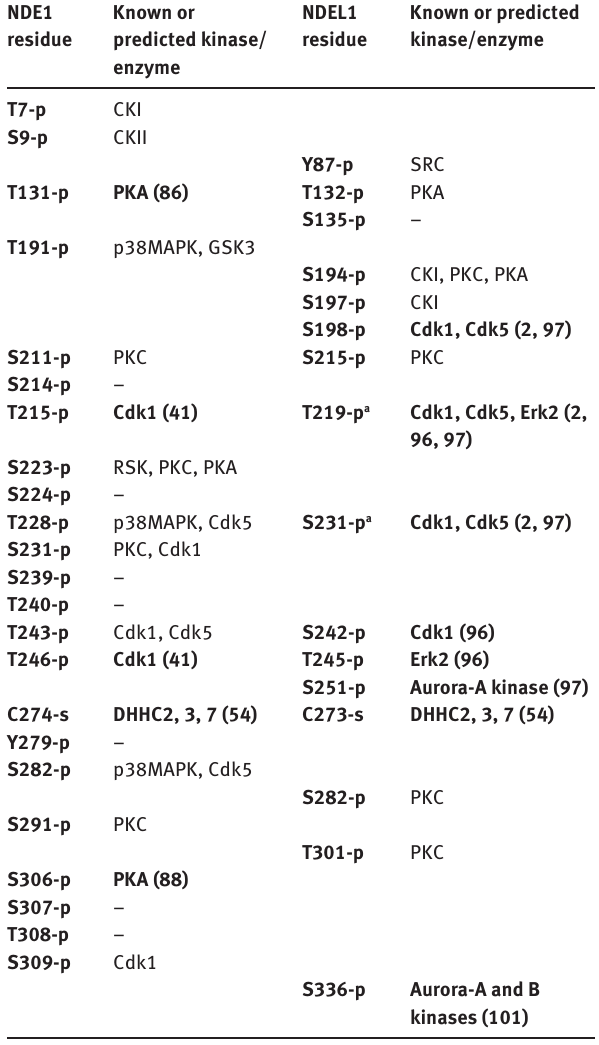
Table 2 Post-translational modification on NDE1 and